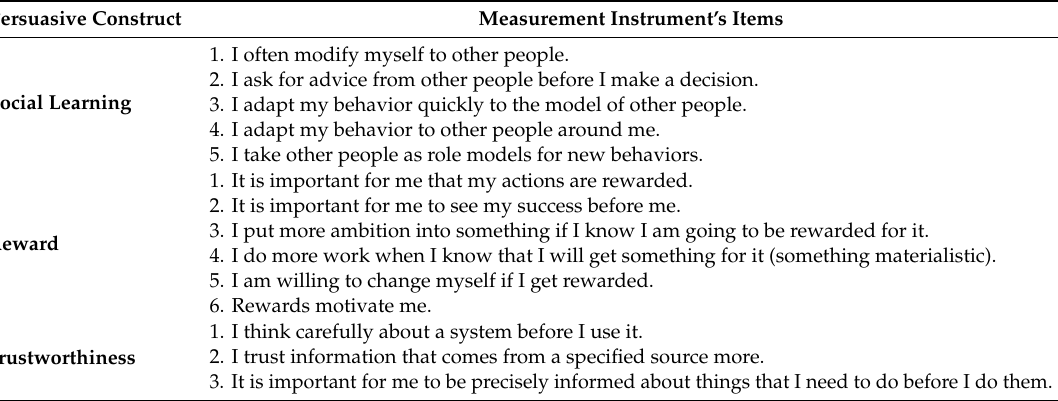
Table 2. Study’s measurement instrument